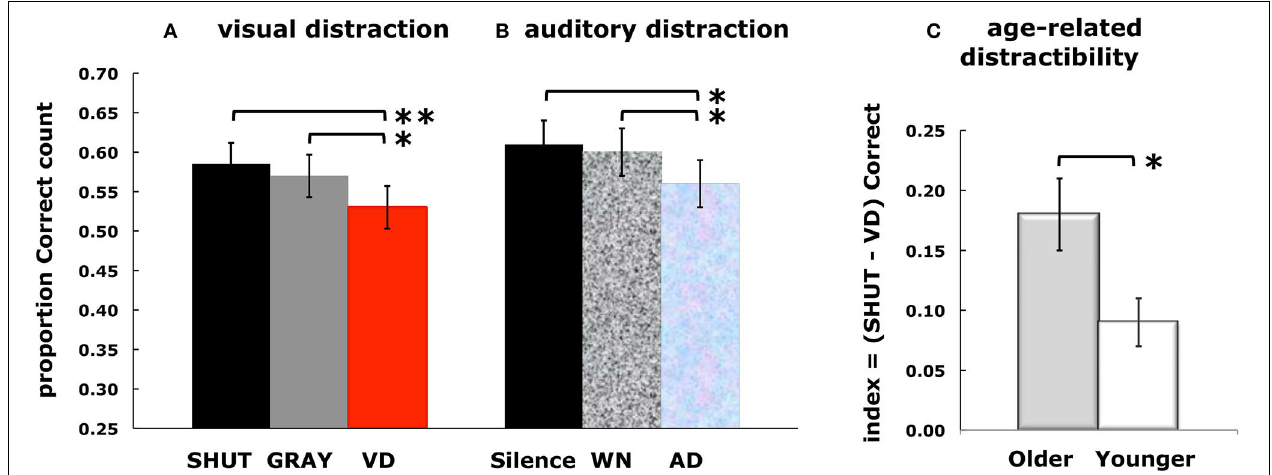
FIGURE 2 | Results from behavioral experiments. Episodic retrieval scores are presented for three studies that used separate groups of participants. Each panel shows the negative influence of external distraction. For visual distractors (A) , the mean proportion of targets given responses with the correct count by a group of younger adults is diminished in the visual distraction (VD) condition relative to the SHUT and GRAY conditions. For auditory distractors (B) , the results from younger adults show the same